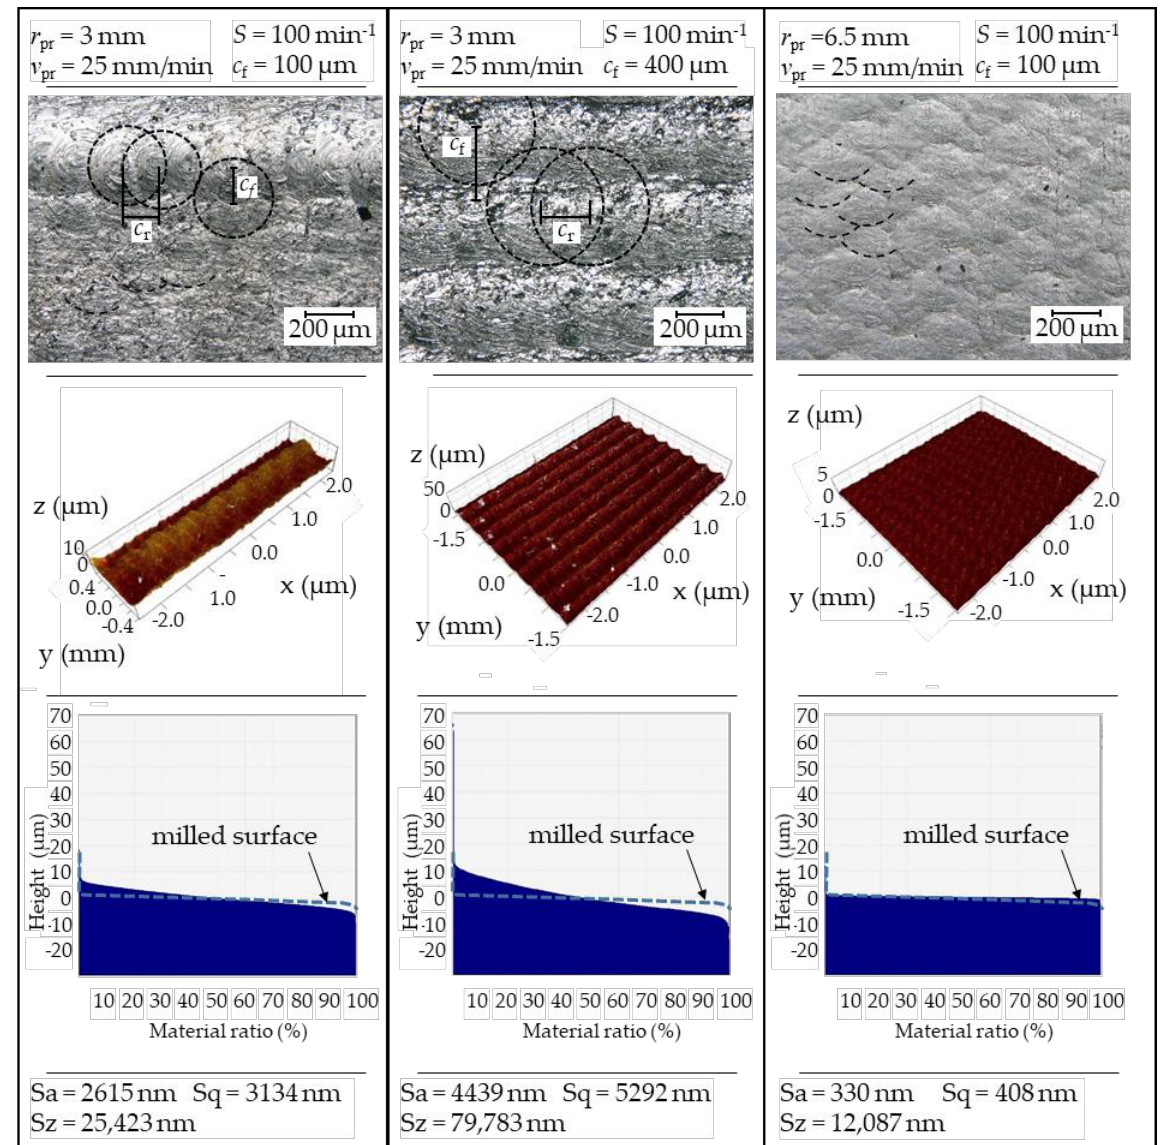
Figure 9. Microscopic surfaces ( top ), coherence scanning interferometer surfaces ( middle ), and Abbott curves ( bottom ) for the conducted PMST experiments with varied tool sizes and track-offset c f .